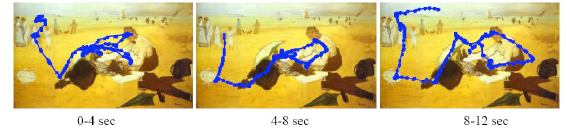
Figure 2. One of the control stimuli; "Beach Scene" by Degas, 1905. The viewer's eye movements start from the two figures in the center and then continues on the left to finally fixate the group of people walking on the top left corner of the image. This seems to be very consistent for the three different viewing